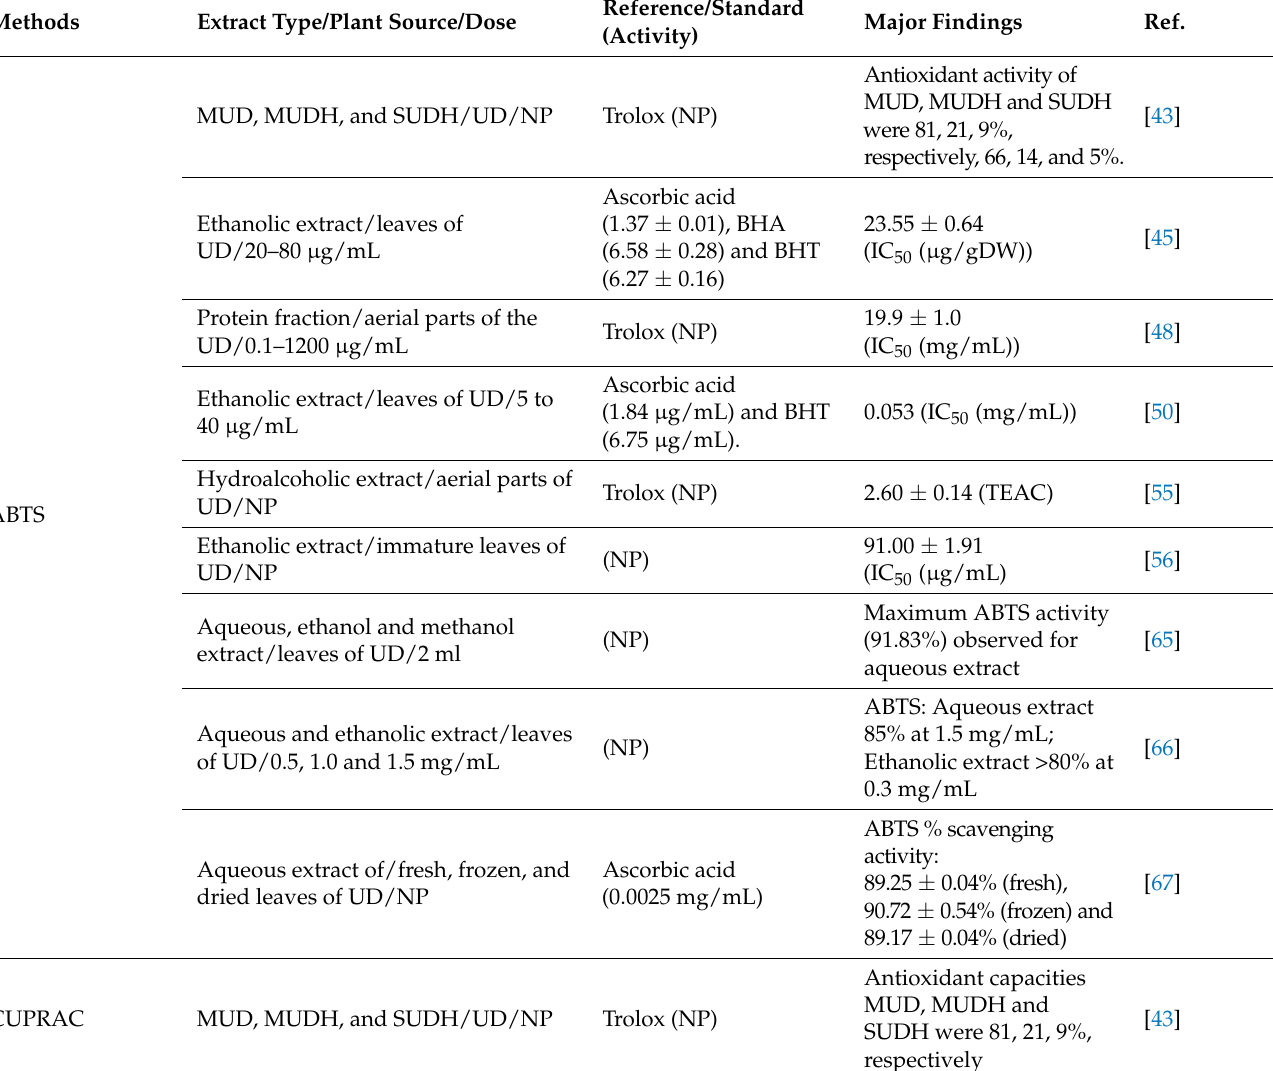
Table 1. Antioxidant activities of UD through in vitro